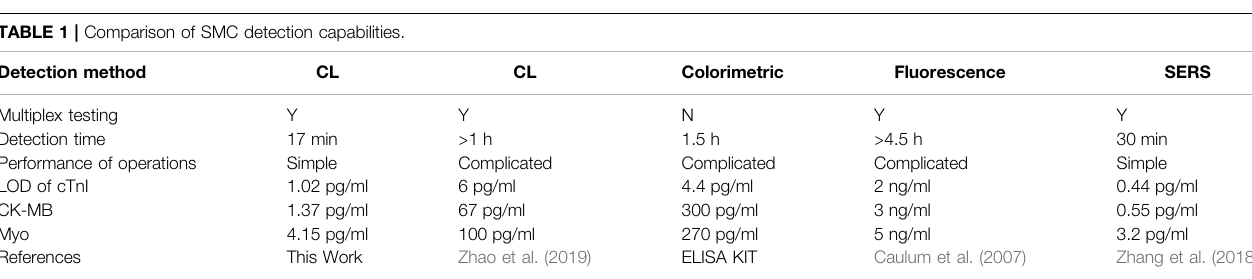
TABLE 1 | Comparison of SMC detection